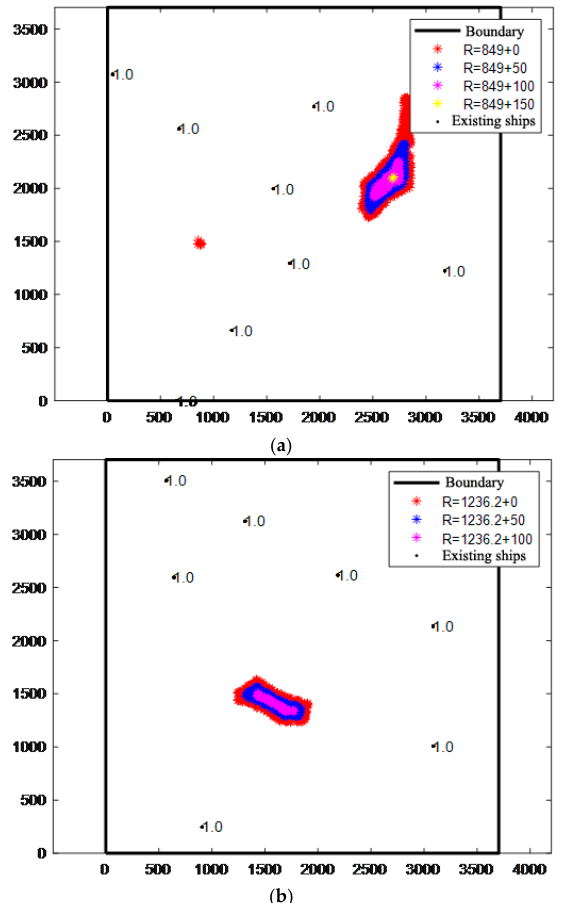
Figure 11. Schematic diagram of mooring area detection with wind force ≤ 7 and water depth of 40 m. ( a ) Represents 192 m and 192 m ship type mooring area detection. ( b ) Represents 333 m and 333 m ship type mooring area detection.